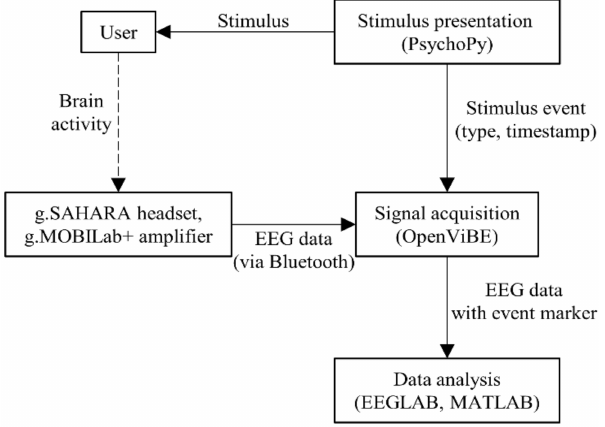
Figure 3. Overall EEG recording system [39].